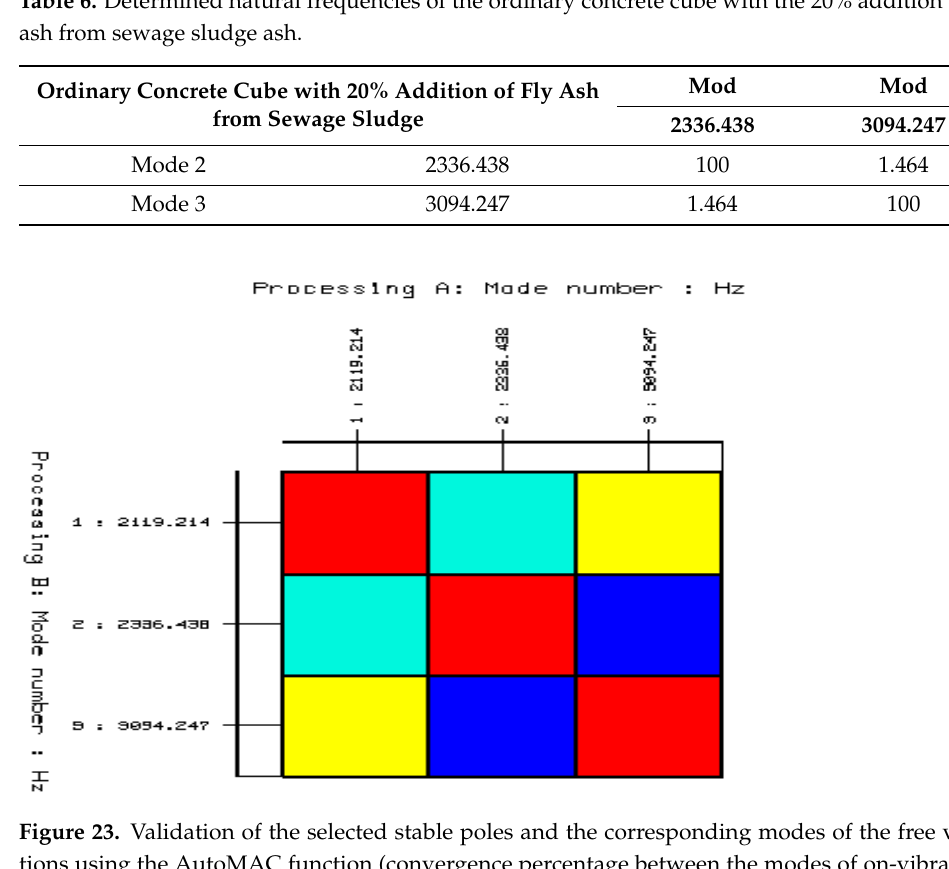
Table 6. Determined natural frequencies of the ordinary concrete cube with the 20% addition of fly ash from sewage sludge ash.